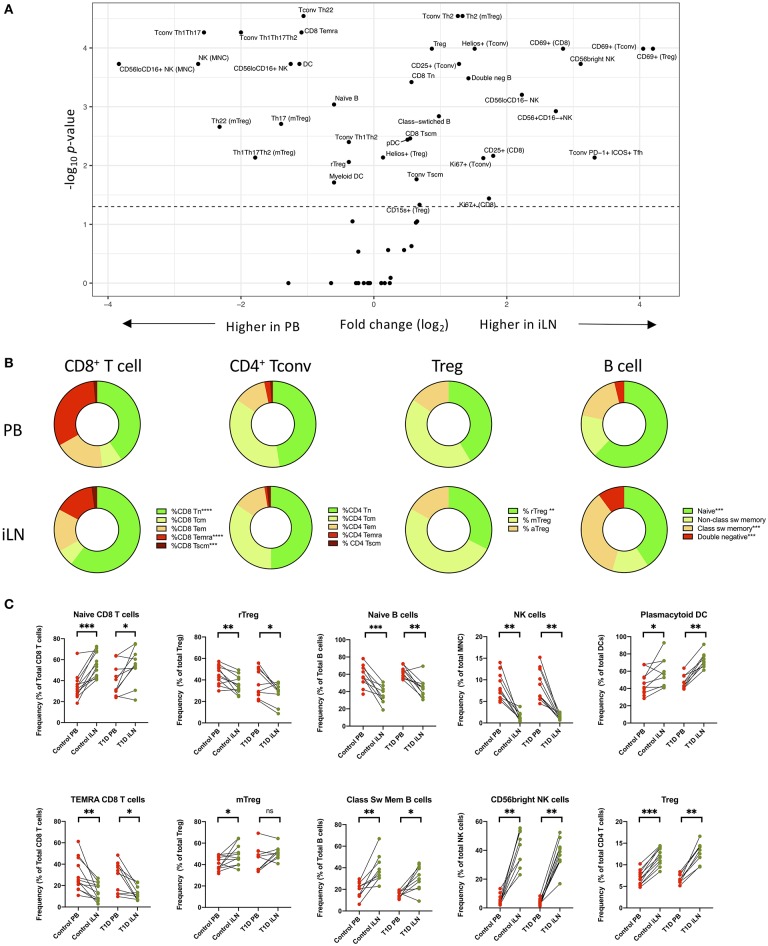
Differences in immune cell subsets between blood and iLN in control and T1D subjects. (A) Volcano plot showing fold difference in the frequency of cell populations on the x-axis and significance of the difference on the y-axis (-Log10
p-values) for blood and combined iLN from pooled control and T1D subjects. P-values were calculated adjusting for multiple comparisons using the Holm-Sidak method. (B) Doughnut plots showing the distribution of naïve and memory CD8+ and CD4+ T cells, Treg and B cells in blood and iLN from pooled control and T1D subjects. Significance is calculated as described for panel A. (C) Paired frequencies of key individual cell populations showing different frequencies in blood and iLN from control and T1D subjects. Student's t-test or Wilcoxon signed-rank test was used. *p < 0.05, **p < 0.01, ***p < 0.001, ****p < 0.0001, ns, not significant; sw, switched.